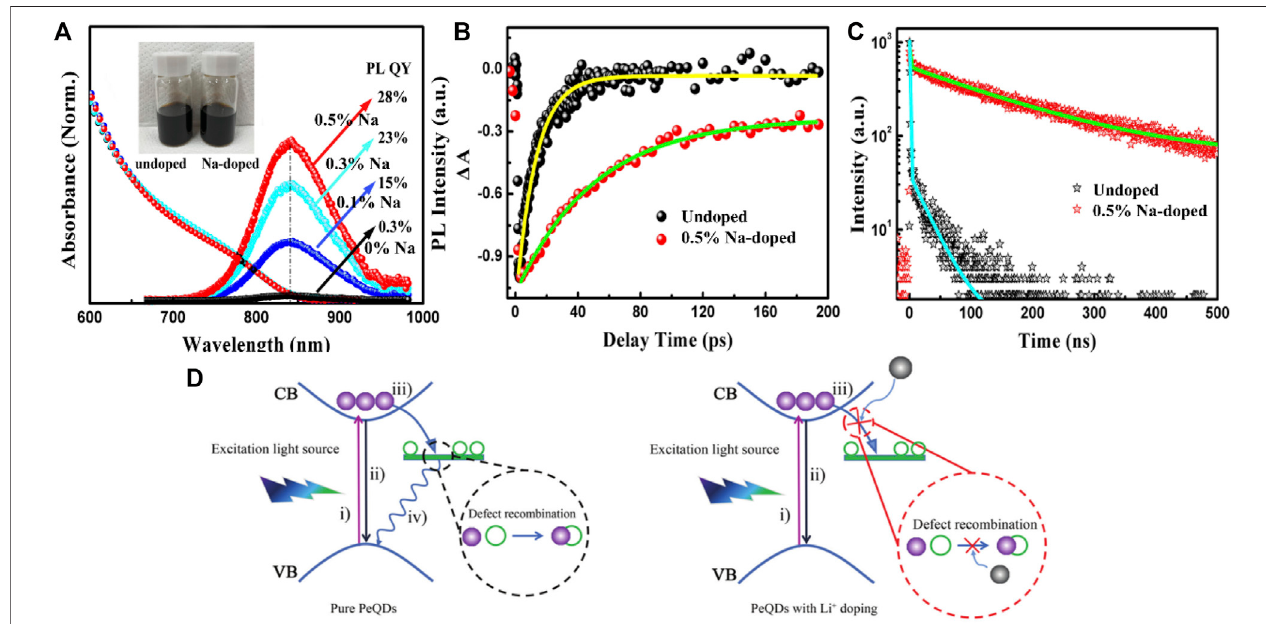
FIGURE2|(A) UV-visand PLspectraoftheQDswithand withoutNa + doping; (B) NormalizedTAkineticpro fi lesand (C) TRPLdecayoftheQDs(Liuetal.,2020); (D) The schematic diagram of photocarrier recombination mechanism (Wu et al., 2021).